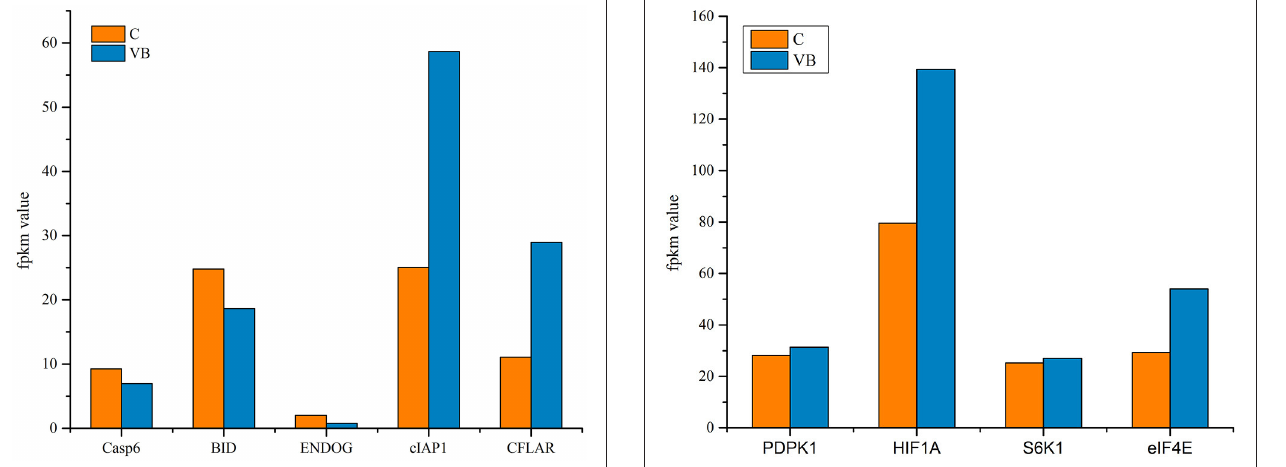
FIGURE 17 | Genes related to mTOR signaling pathway.